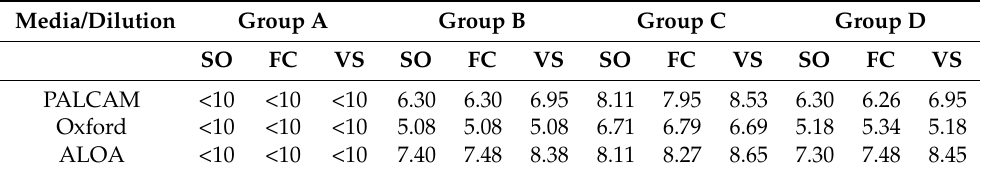
Table 1. Results a of the determination of Listeria monocytogenes in different foods by traditional methods and the VIDAS ( n = 4 for each group of foods). Media/Dilution